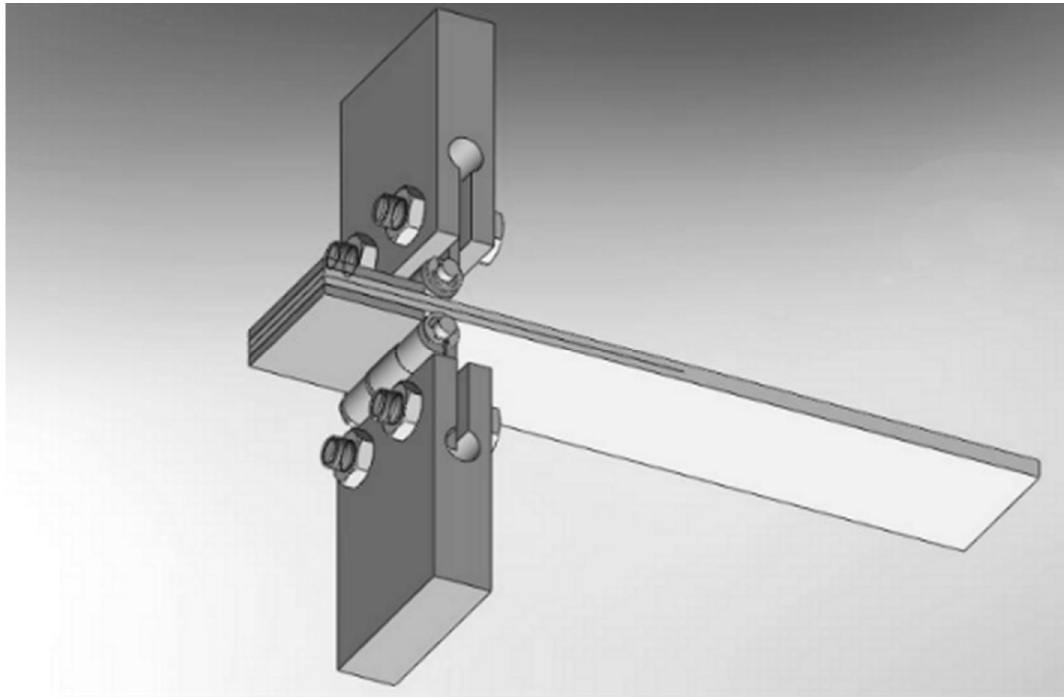
Figure 1. Mode I delamination test: schematic of the equipment.